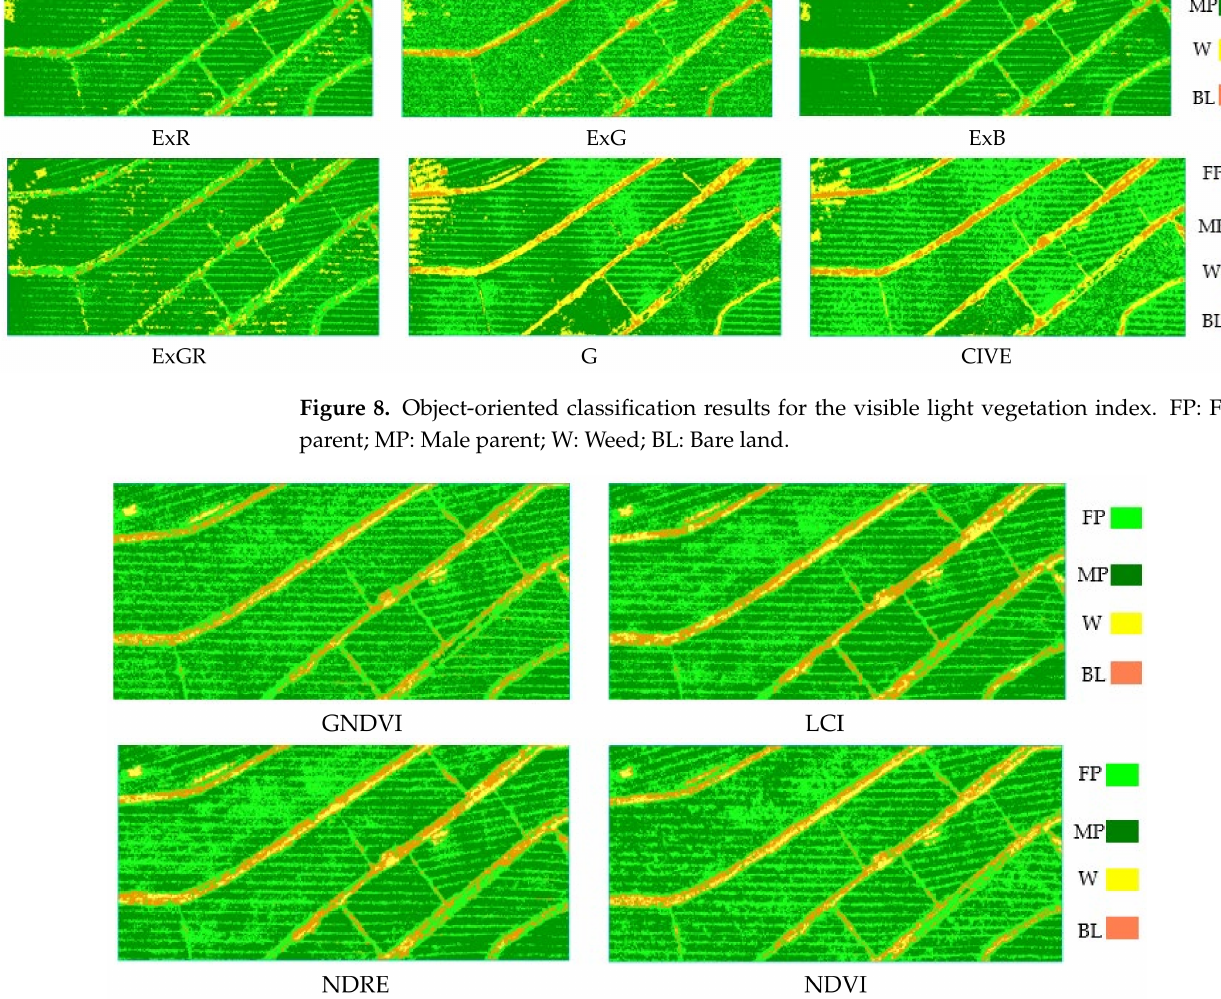
Figure 9. Object-oriented classification results for the multispectral vegetation index. FP: Female parent; MP: Male parent; W: Weed; BL: Bare